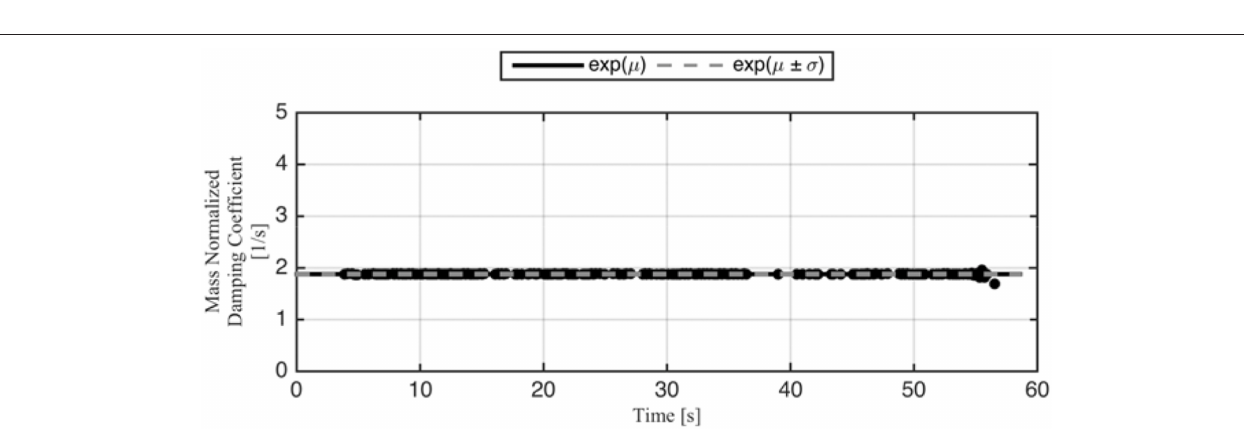
of damping. In each case the effective viscous damping ratios estimated using the algorithm matches the value set for the corresponding